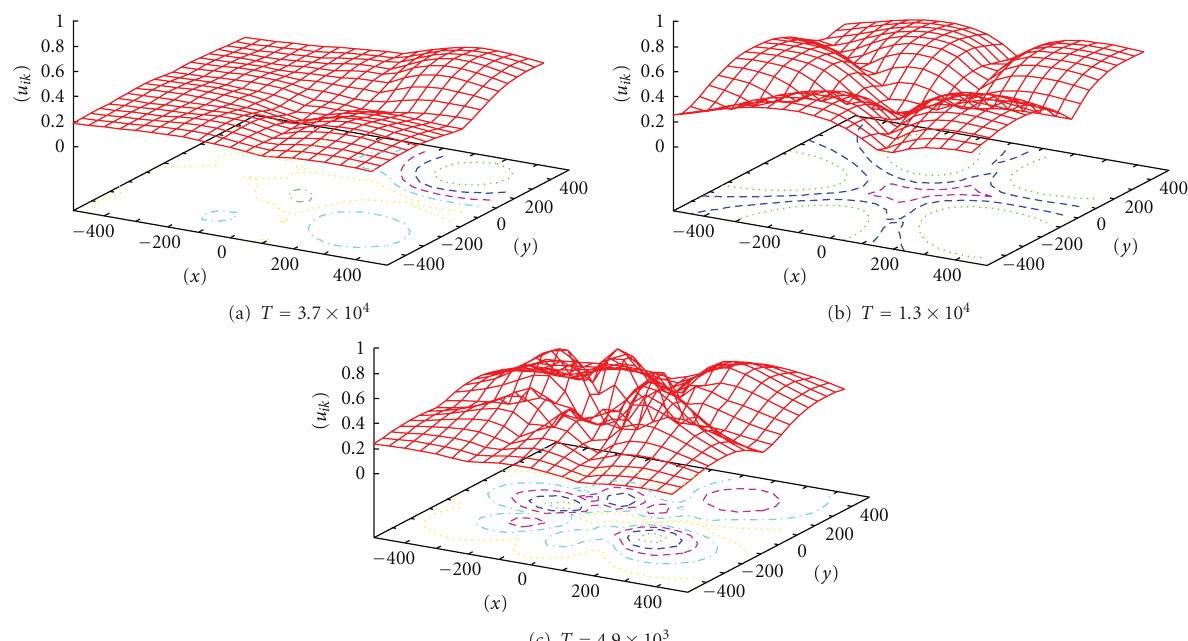
Figure 10: The changes of the landscape of (cid:11) u ik with decreasing the temperature ( q = 1 .